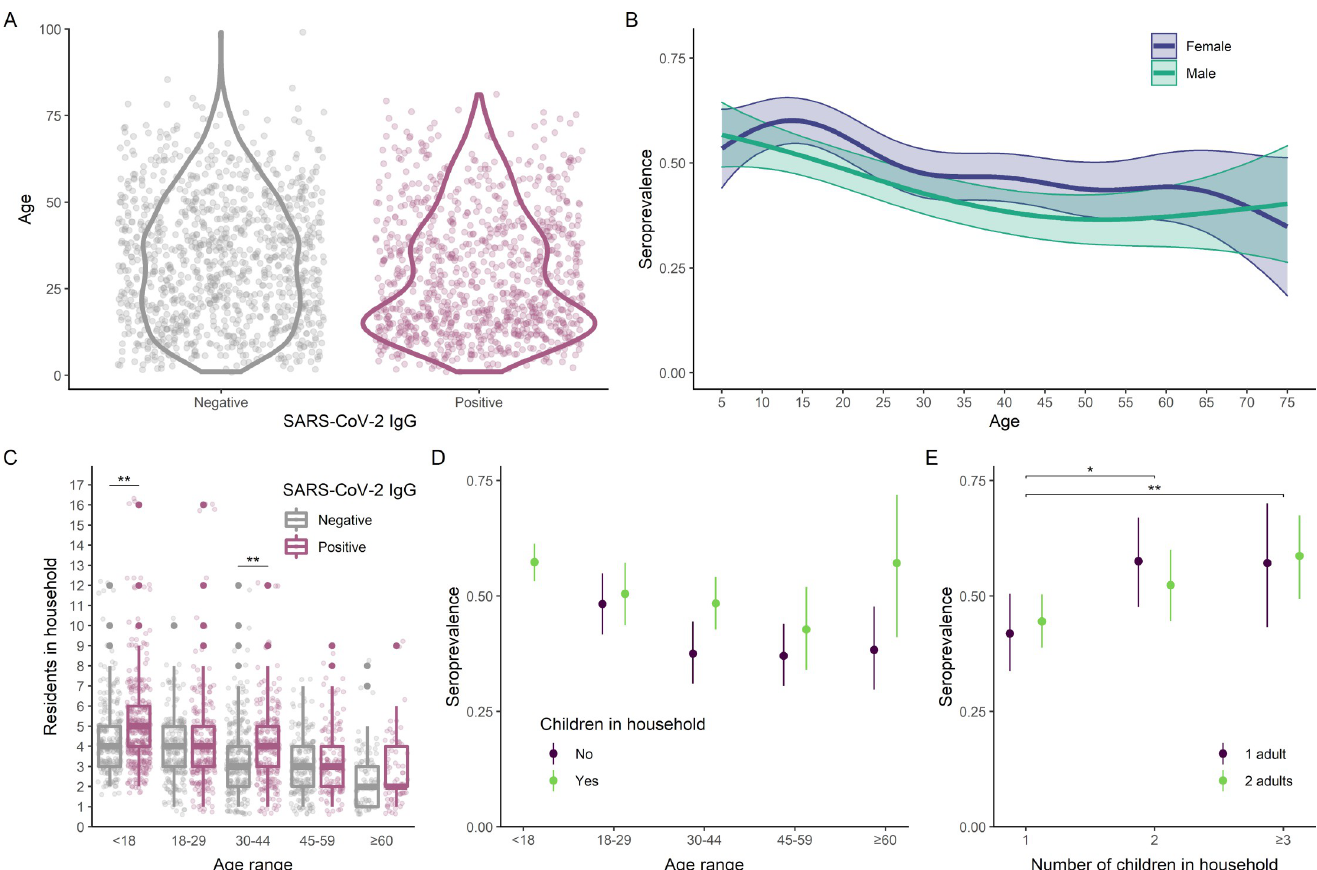
Fig 2. Seroprevalence among children and in their households. (A) Age distribution of SARS-CoV-2 seronegative (median 32 years, IQR 19–46) and seropositive (median 25 years, IQR 15–41) individuals. (B) SARS-CoV-2 seroprevalence and 95% CI associated with age, as estimated with a generalized additive model. (C) Distribution of household size by age among SARS-CoV-2 seronegative and seropositive individuals. Seropositive individuals tended to be in larger households compared to seronegative individuals in the same age group. (D) Seroprevalence and 95% CI stratified by age group and presence of children in the household. (E) Variation in seroprevalence among children by household composition (number of children and number of adults). The number of other children in the household was associated with higher seroprevalence, but there was no statistically significant difference between households with 1 adult and those with 2 adults. Asterisks indicate statistically significant differences (2-tailed t test, Bonferroni-adjusted p < 0.05: � ; < 0.01: �� ; < 0.001: ��� ; α = 0.01, 0.0125, 0.0167 in panels (C–E). CI, confidence interval; IQR, interquartile range; SARS-CoV-2, Severe Acute Respiratory Syndrome Coronavirus 2.